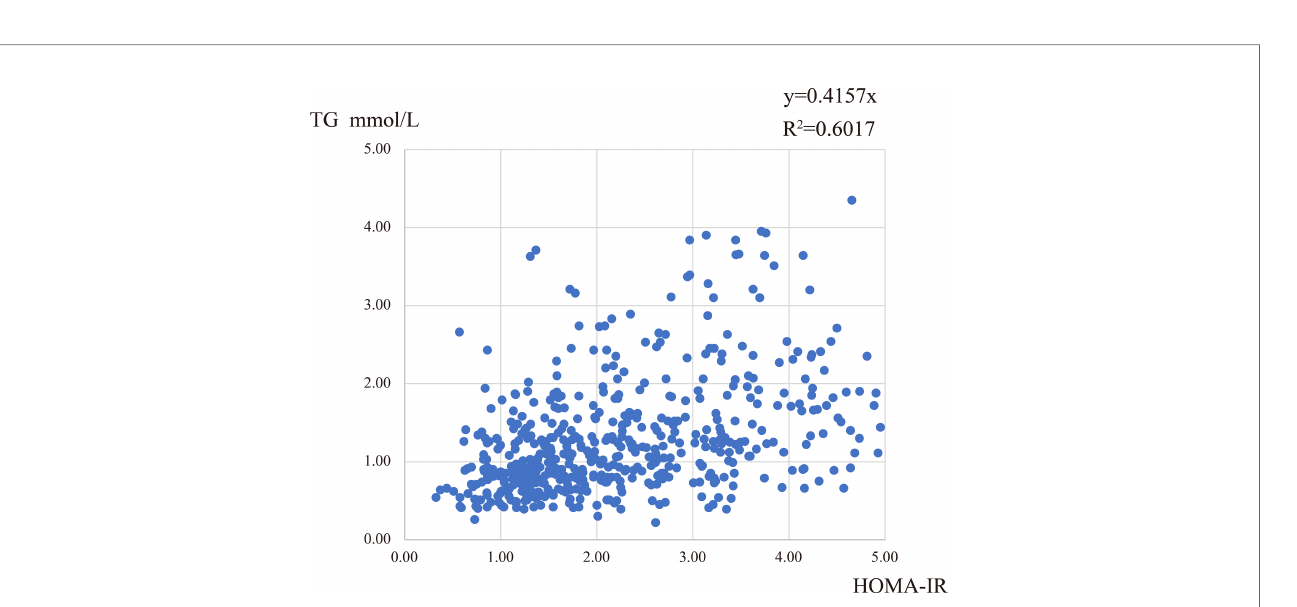
FIGURE 2 | The correlation between TG and